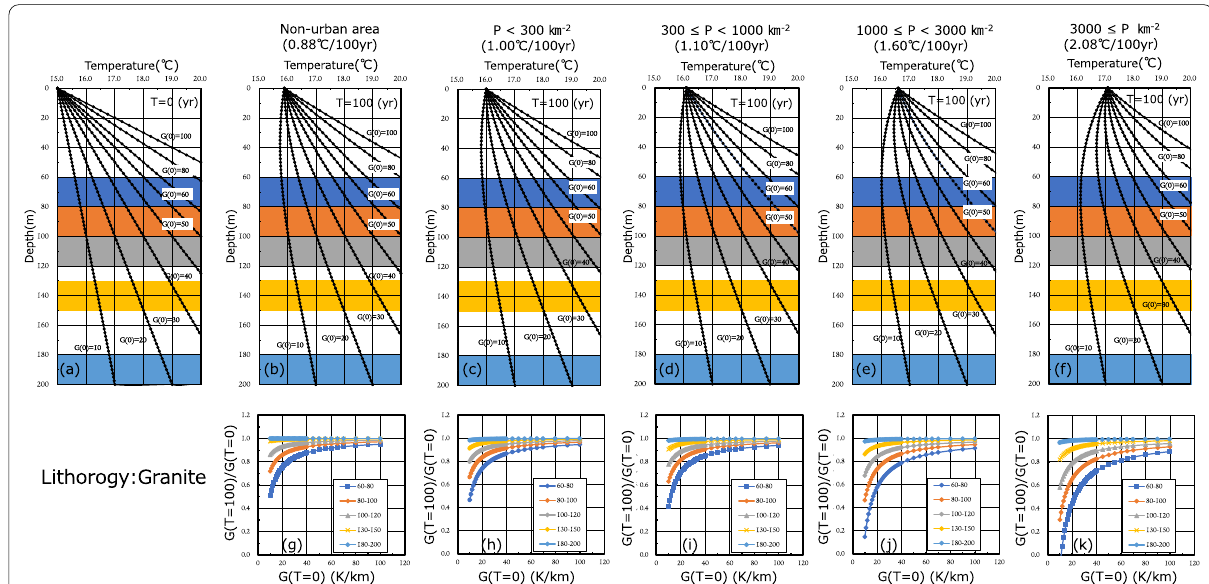
Fig. 4 Assessing the impact of climate change on temperature gradients at different depths. Changes in temperature profile associated with climate change. Lithology is granite. Temperature gradients are shown in 8 cases: 10 K km − 1 , 20 K km − 1 , 30 K km − 1 , 40 K km − 1 , 50 K km − 1 , 60 K km − 1 , 80 K km − 1 , and 100 K km − 1 . a The initial condition, and b , c , d , e , and f show the condition after 100 years. Based on Fujibe (2012), the trend of temperature rise over the past 100 years is expressed using five cases (0.88 °C per 100 years, 1.00 °C per 100 years, 1.10 °C per 100 years, 1.60 °C per 100 years, and 2.08 °C per 100 years) according to population density. g , h , i , j , and k show the temperature gradient ratios after 100 years from the initial condition for these five cases. Calculations are performed for each of the five intervals (60–80 m, 80–100 m, 100–120 m, 130–150 m, 180– 200 m) shown in b , c , d , e and f . If the observed temperature gradient is Gobs, the corrected temperature gradient is Gcor, the temperature gradient